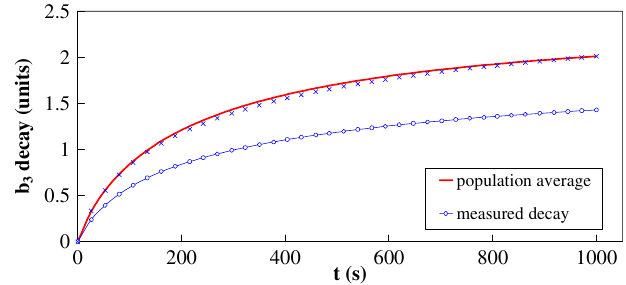
, b , and b , respec- 1 3 5